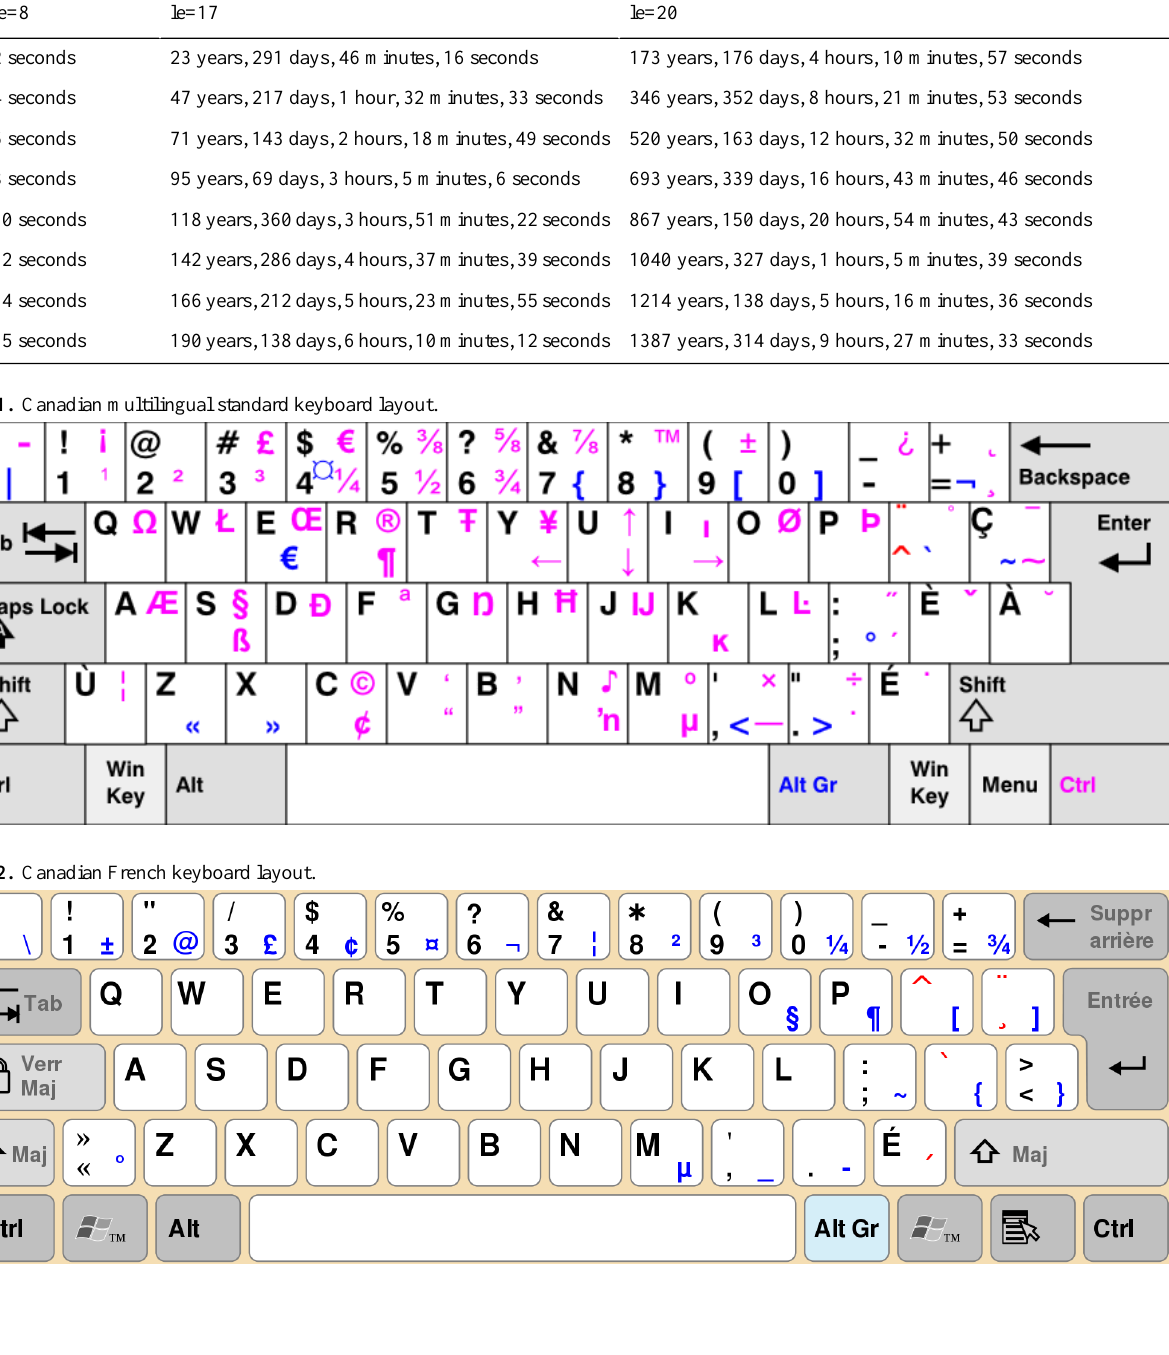
Table 3. Strength of original PsychoPass method for different parameter settings. le=20le=17le=8n s